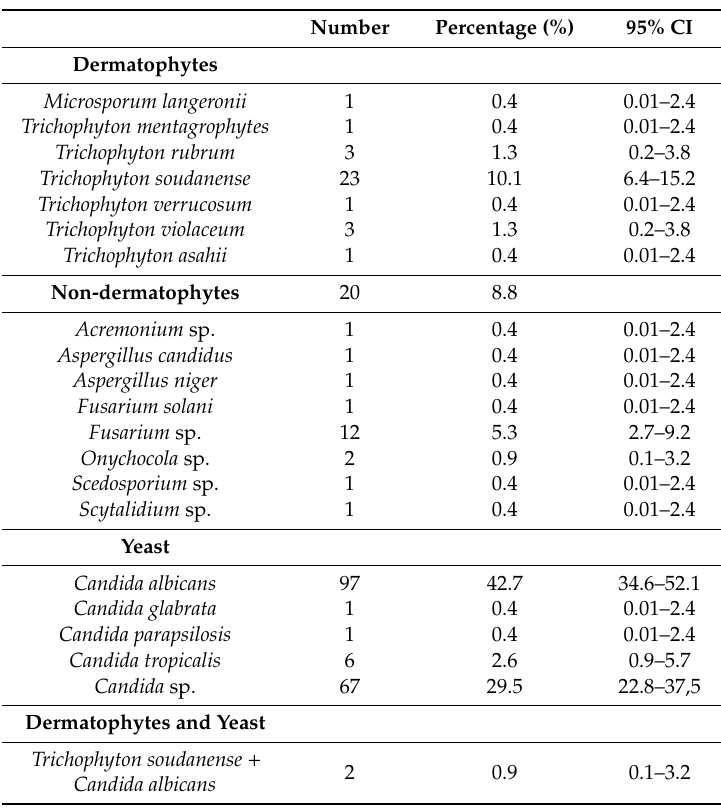
Table 3. Isolated fungal species ( n = 227).